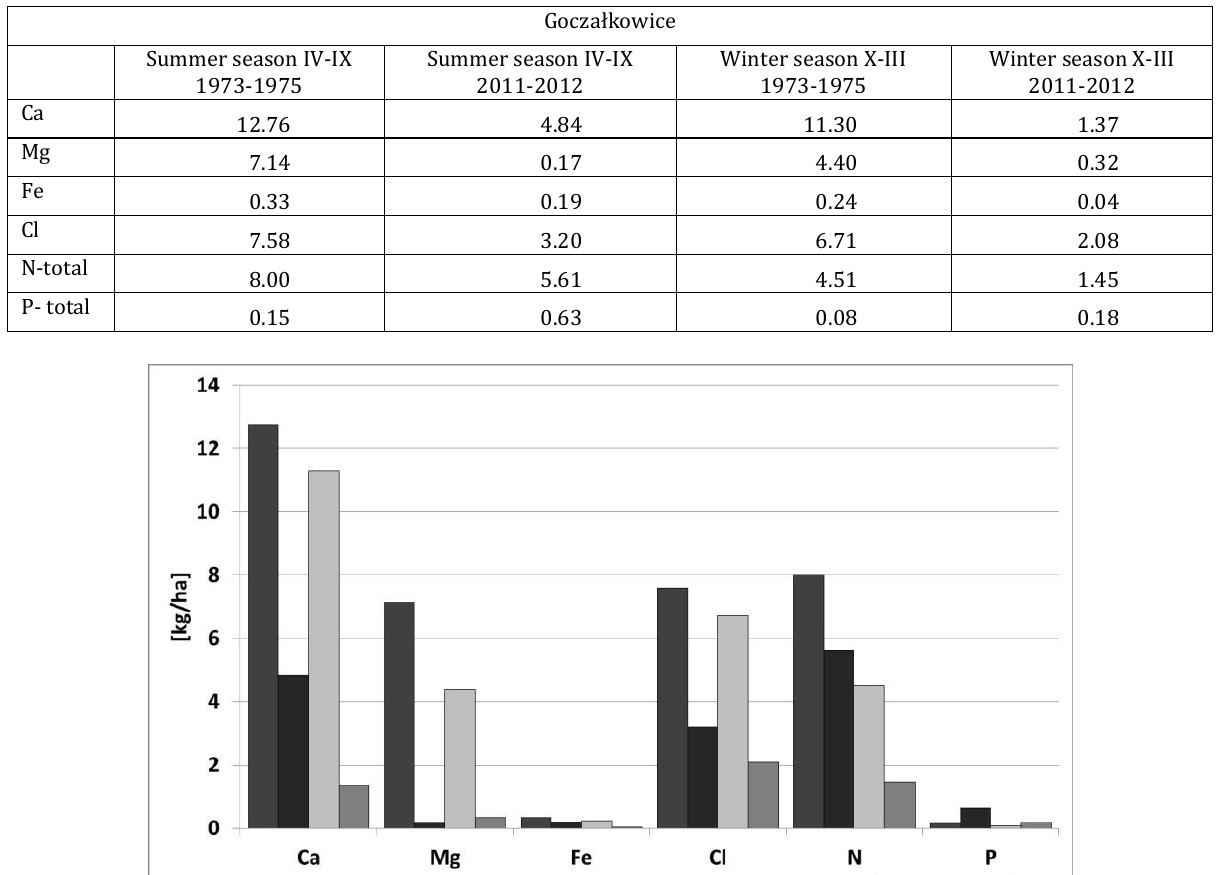
Table 4. Mean seasonal pollutant load values for the periods 1973-1975 and 2011-2012 for Goczałkowice [kg·ha -1 ]